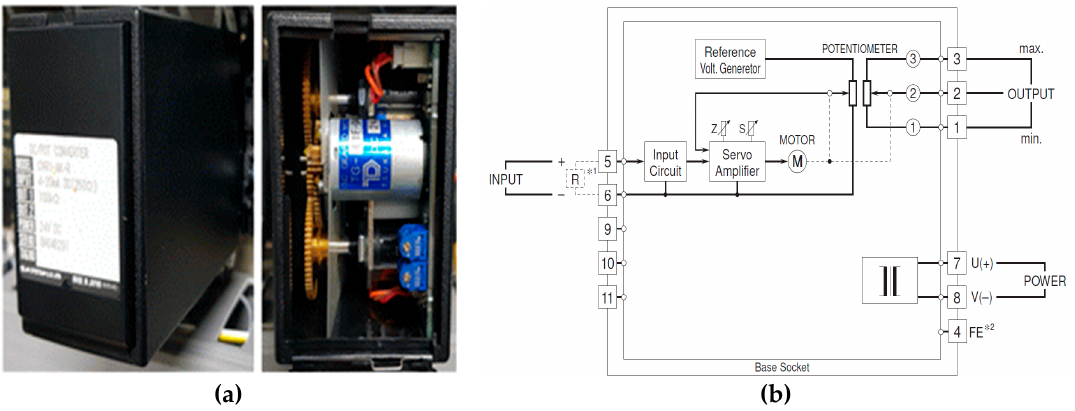
Figure 12. ( a ) Physical structure and ( b ) internal circuit diagram of potentiometer .